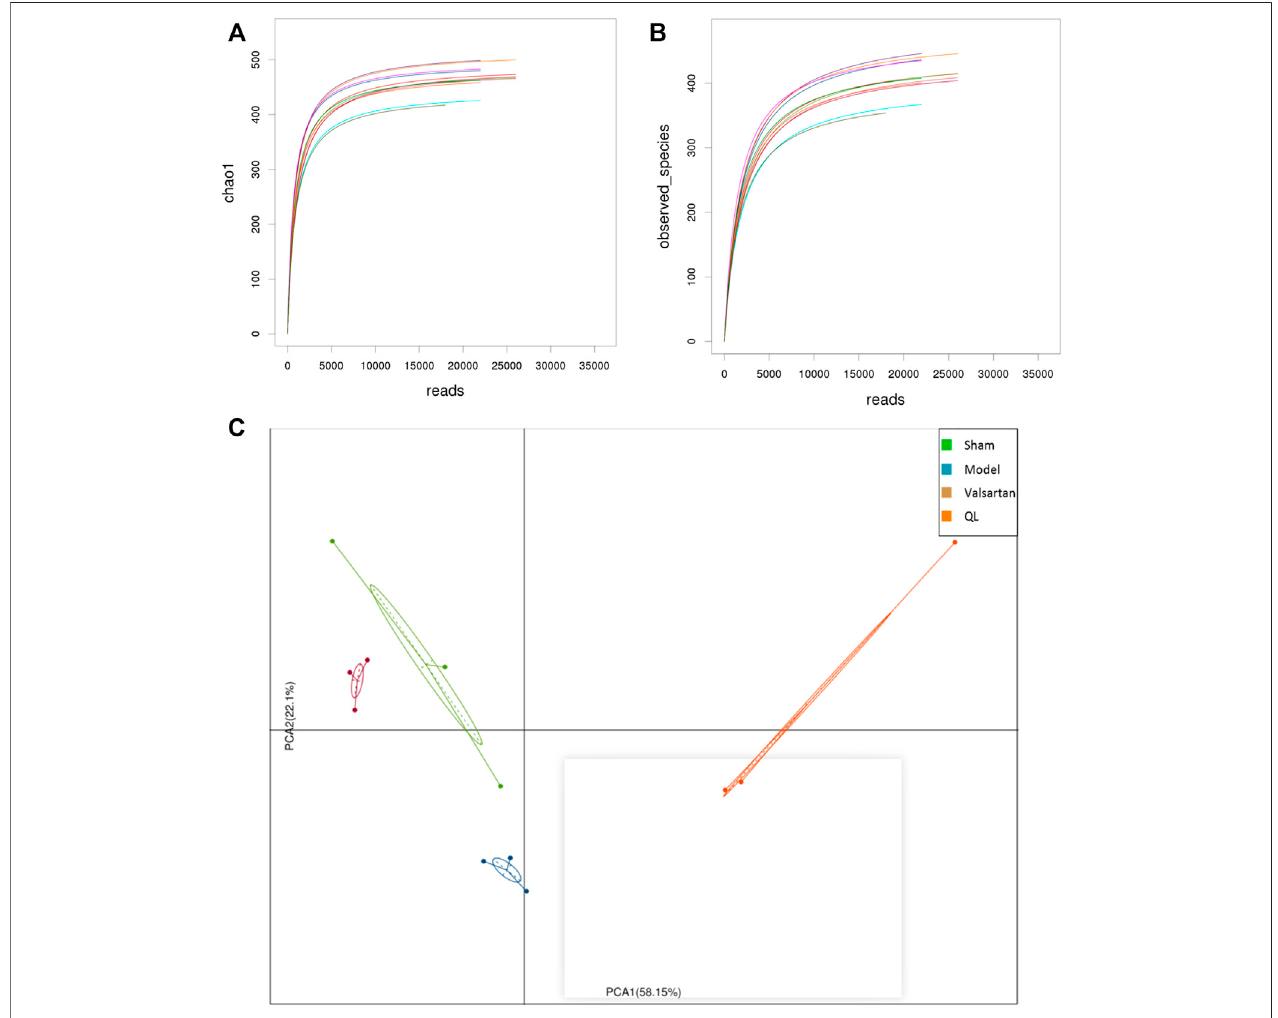
FIGURE 3 | QL regulates the composition of gut microbiota. (A,B) Dilution curves of species richness alpha diversity in samples. (C,D) PCA results of different microbiota, respectively, in all levels and the genus level. (E,F) Relative abundance of gut microbiota at the genus level. The data are the mean ± standard deviation ( (cid:1) x ± s ) (n = 3 per